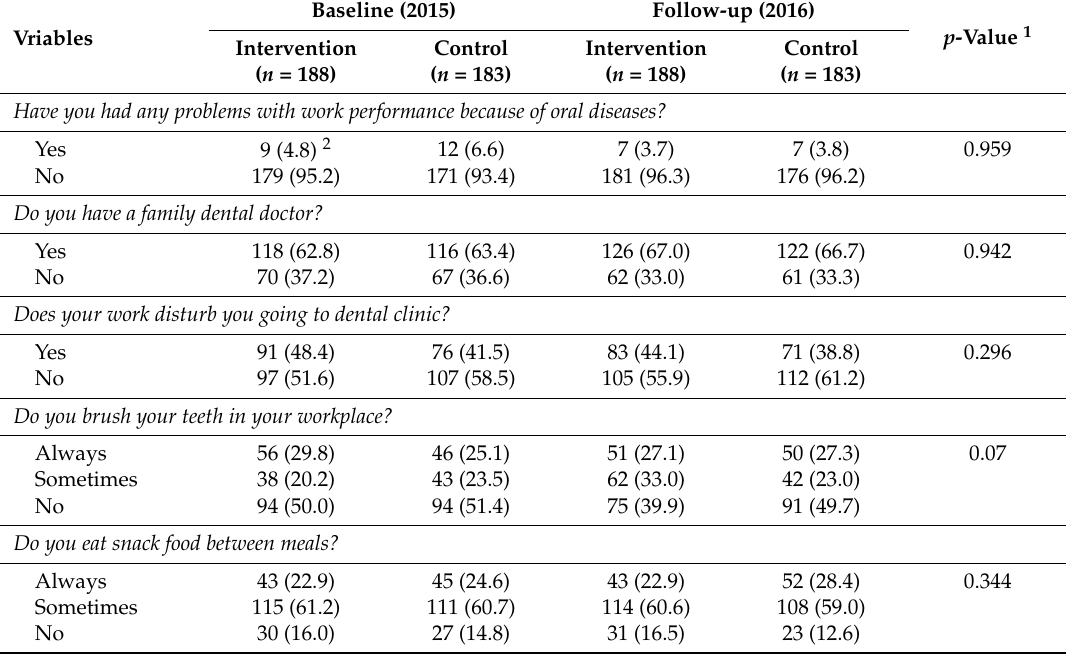
Table 3. Comparison of qualitative variables between the intervention group and the control group at